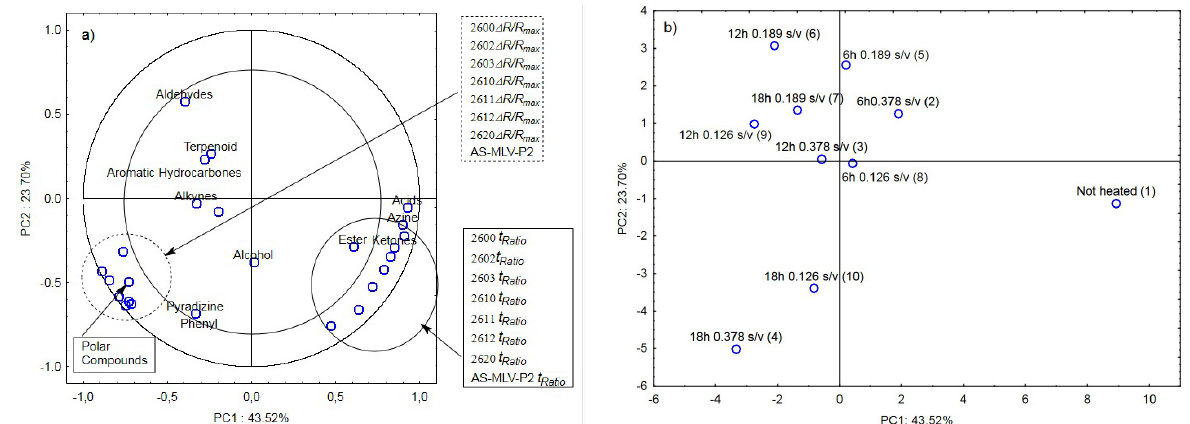
Figure 6. ( a )—Plot of two principal component loadings (PC1, PC2) from eight sensor readings ( ∆ R/R max , t Ratio ; AS brief names of sensors—AS-MLV-P2; 2600, 2602, 2603, 2610, 2611, 2612, 2620—brief names of sensors Figaro—TGS series), volatile compounds (A-alcohols, AC-acids, E-esters, T-terpenoids, K-ketones, AL-aldehydes, PH-phenyls, ARH-aromatic hydrocarbons, AZ-azines, P-pyradizines, ALK-alkynes) and polar compounds obtained for heated oils: 0.378 s/v ratio; 0.189 s/v ratio; 0.126 s/v ratio and control samples; frying time: 6 h, 12 h, 18 h; ( b )—Plot of two principal component scores (PC1, PC2) from eight sensor readings, volatile compounds, polar compounds obtained for heated and control samples oil (the same description of names as in Figure 6a).